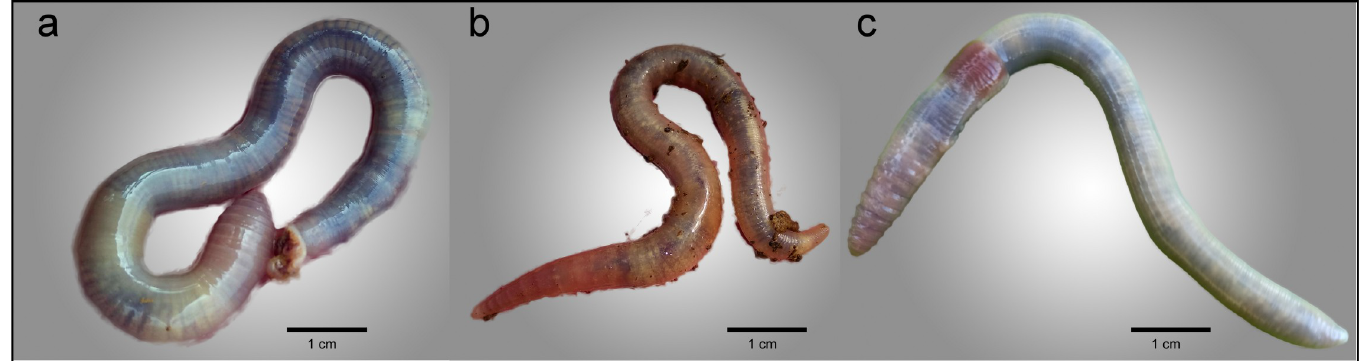
Fig 2. External morphology of living specimens of a) Gatesona rutena b) Gatesona lablacherensis c) Gatesona serninensis .